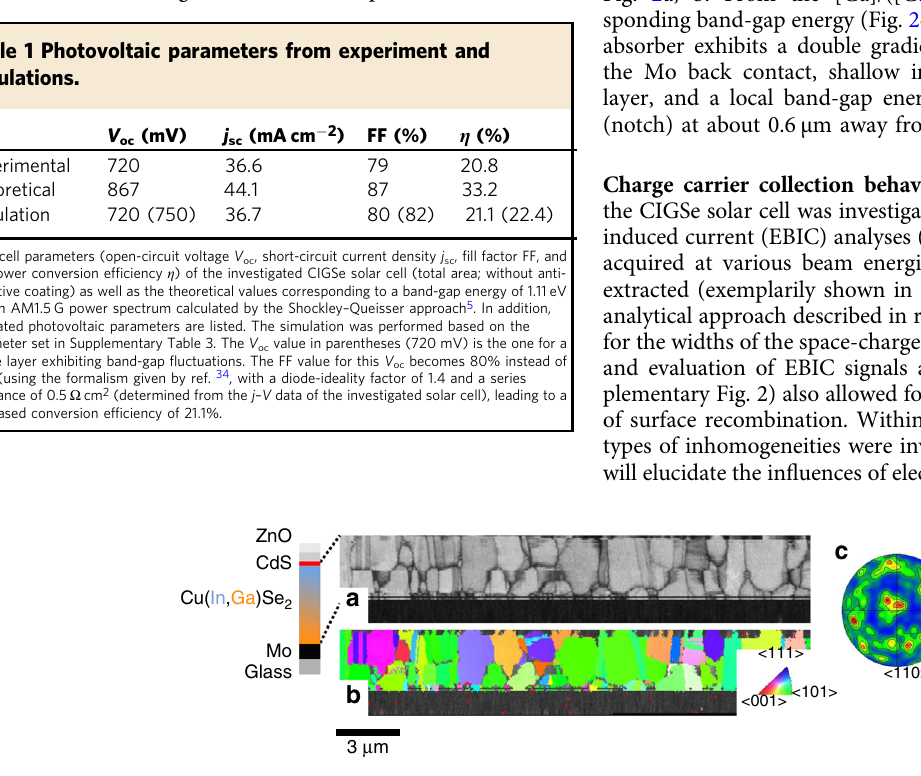
Fig. 1 Electron backscatter diffraction maps. a Cross-sectional EBSD pattern-quality map of the CIGSe in the analyzed solar cell stack and b orientation distribution map with local orientations perpendicular to the substrate highlighted by false colors within the related inverse pole fi gure, as well as c the pole fi gure for the <110> orientation (with the multiples of random values given by false